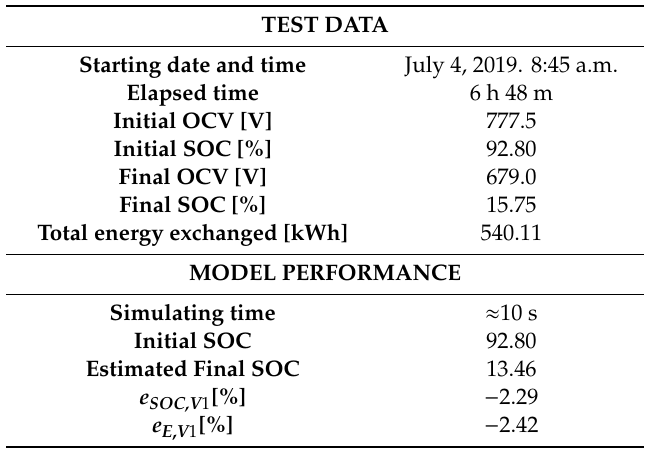
Table 9. Verification test summary.